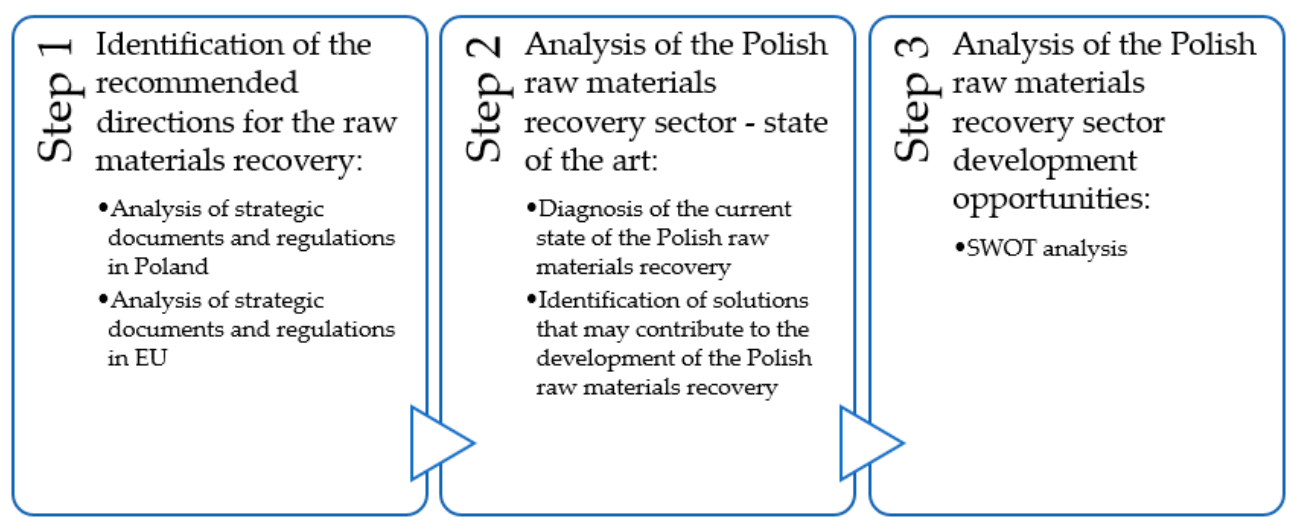
Figure 1. Research Figure 1. Research framework.